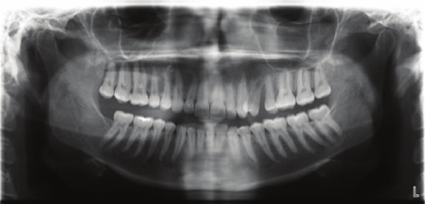
Figure 2: Panoramic radiograph at initial presentation. Interproxi- mal bone loss can be appreciated between teeth numbers 24 and 25 (international nomenclature) and tooth number 24 is noted to be mesially